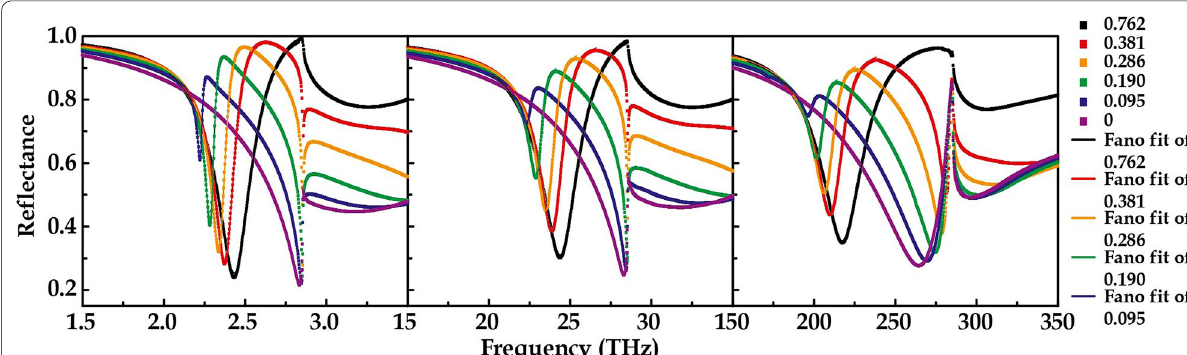
Fig. 2 Simulated reflectance spectra of the asymmetric dipole bars at different regimes of the electromagnetic spectrum - NIR to THz (right to left). Coloured solid lines represent the Fano lineshape fitted to Eq. 1 at different asymmetry